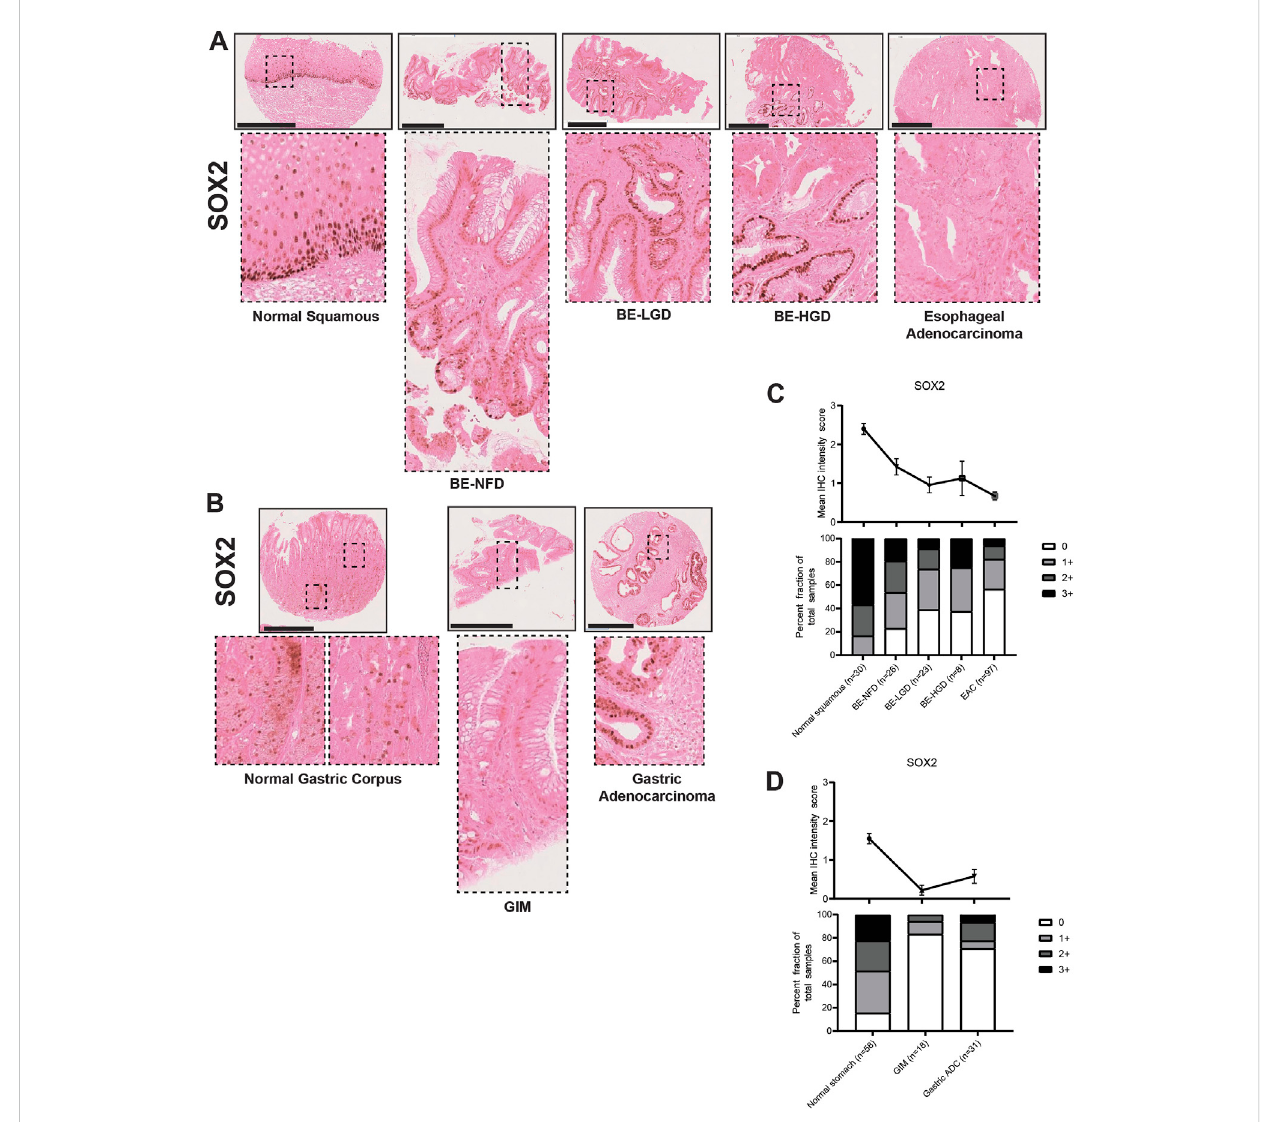
FIGURE 8 SOX2 expression in normal squamous-BE-EAC and normal gastric gland-GIM-GA progression sequence. (A) Immunohistochemistry of SOX2 staining inhuman tissue microarray esophageal cases, inthesame sequence as inFigure 2A. (B) Immunohistochemistry ofSOX2 staining inhuman tissue microarray gastric cases, in the same sequence as in Figure 2B. All scale bars, 500 μ m. (C) Top: the SOX2 average IHC intensity score of each esophageal phenotype is plotted in the same sequence as in Figure 2C. Bottom: the SOX2 fraction of esophageal tissue cores with each score is plotted in the same sequence as in Figure 2C. Each phenotype ’ s total tissue core number is provided at the bottom of each column. (D) Top: the SOX2 average IHC intensity score of each esophageal phenotype is plotted in the same sequence as in Figure 2D. Bottom: the SOX2 fraction of esophageal tissue cores with each score is plotted in the same sequence as in Figure 2D. Each phenotype ’ s total tissue core number is provided at the bottom of each